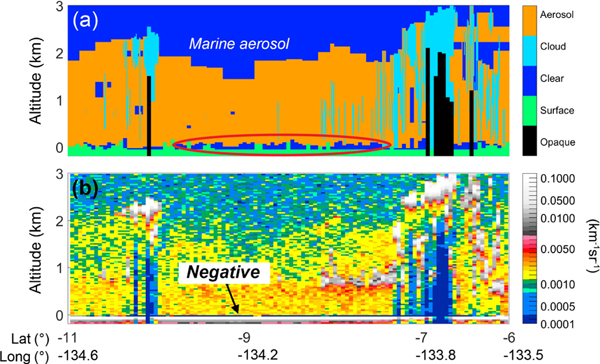
(a) Level 2 feature type classification and (b) level 1B total attenuated backscatter for the granule 2008–08-01T10–17-21ZN passing over the Pacific Ocean. Undetected surface-attached aerosol (circled) and negative attenuated backscatter (arrow) are denoted.